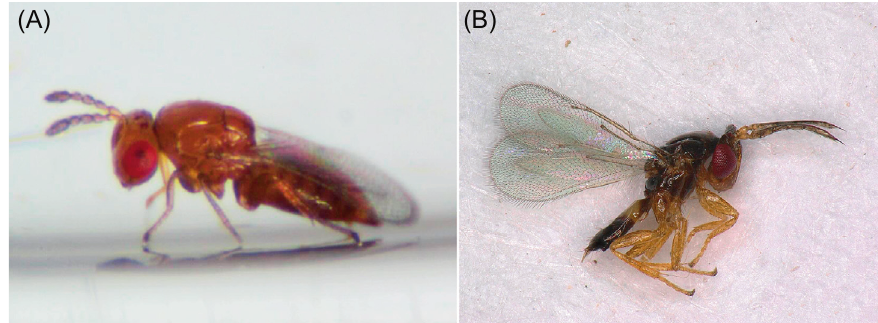
Figure 4. (A) Profile view of Aprostocetus causalis female; (B) profile view of A. causalis male.